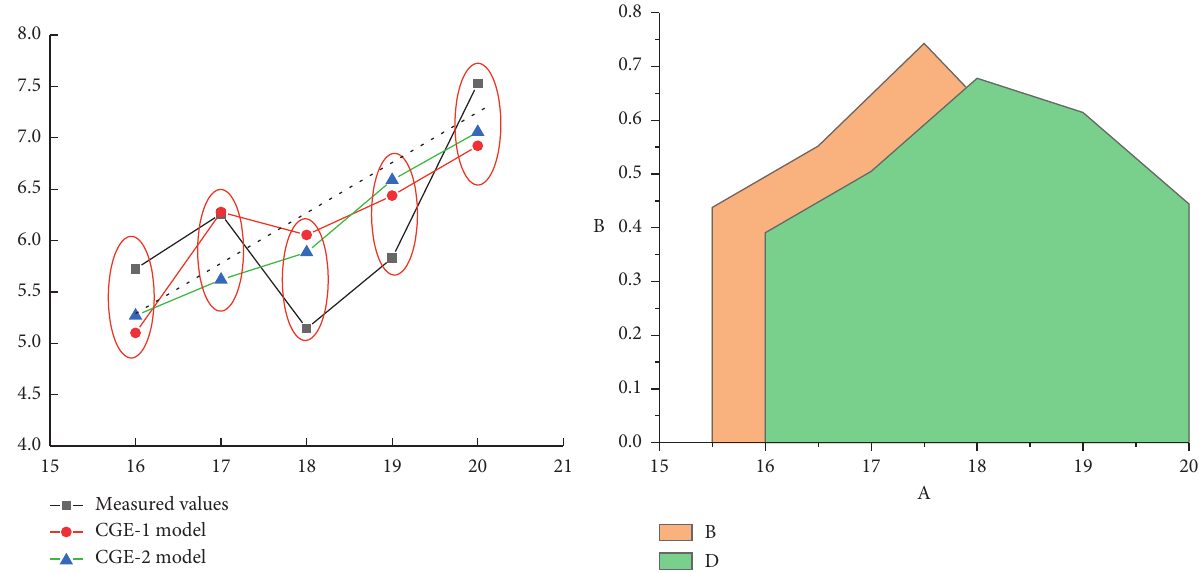
Figure 7: Model processing